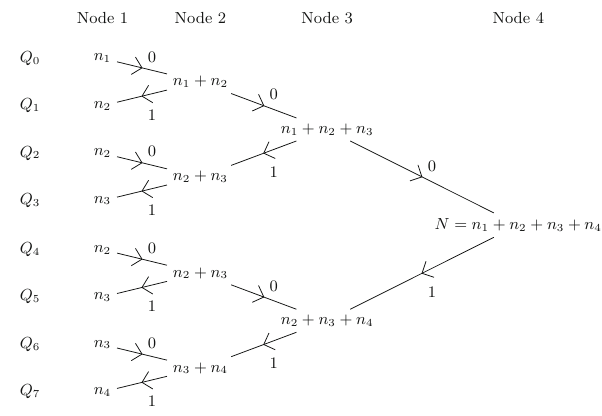
Fig. 10 The linear quivers that are Seiberg-dual to the oriented quiver Q